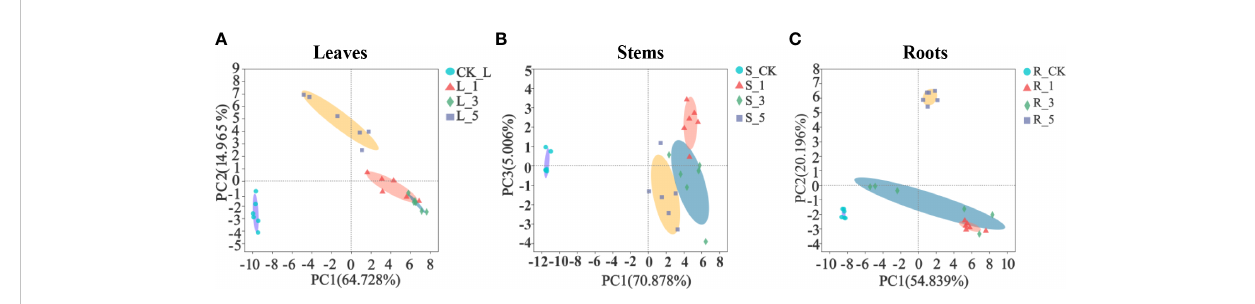
FIGURE 2 Principal component analysis (PCA) of the metabolites in P. notoginseng . (A – C) Represent the leaves, stems and fi brous roots,